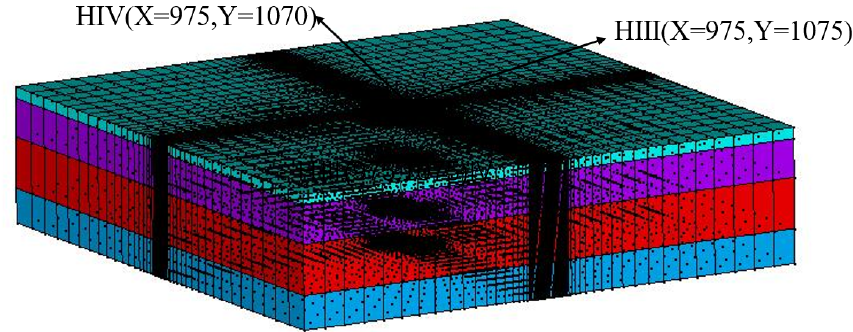
Figure 1. A three-dimensional (3-D) mesh of the